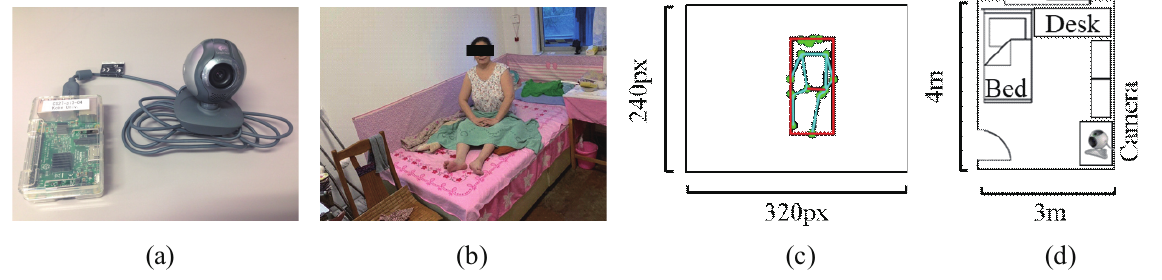
Figure 8. Experimental Setup: ( a ) A Raspberry Pi and a USB camera. ( b ) The experimental room and the elderly requiring care. ( c ) An example of the pose map with the set resolution. ( d ) The environmental layout of target